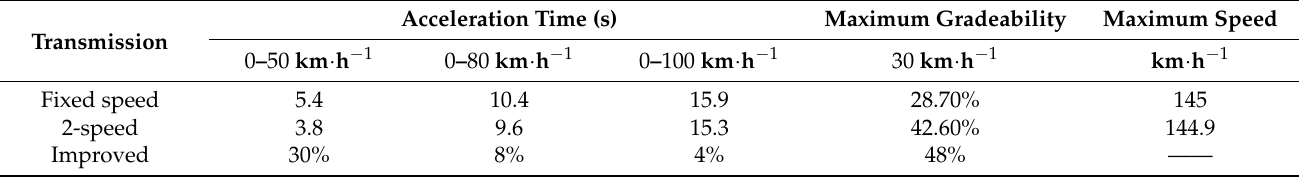
Table 6. Dynamic performance